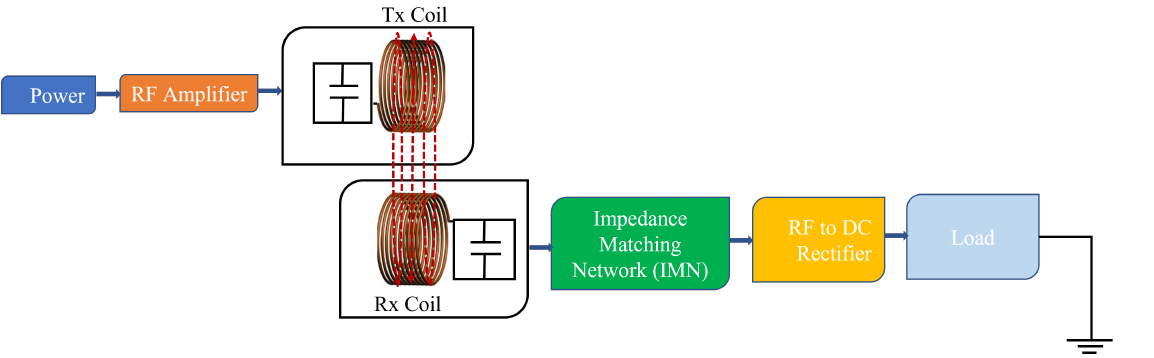
Figure 7. Magnetic resonant coupling for WPT